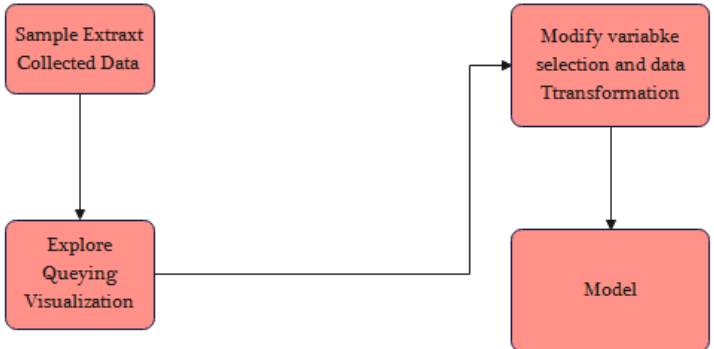
Figure 3. Workflow Process with Data Mining.